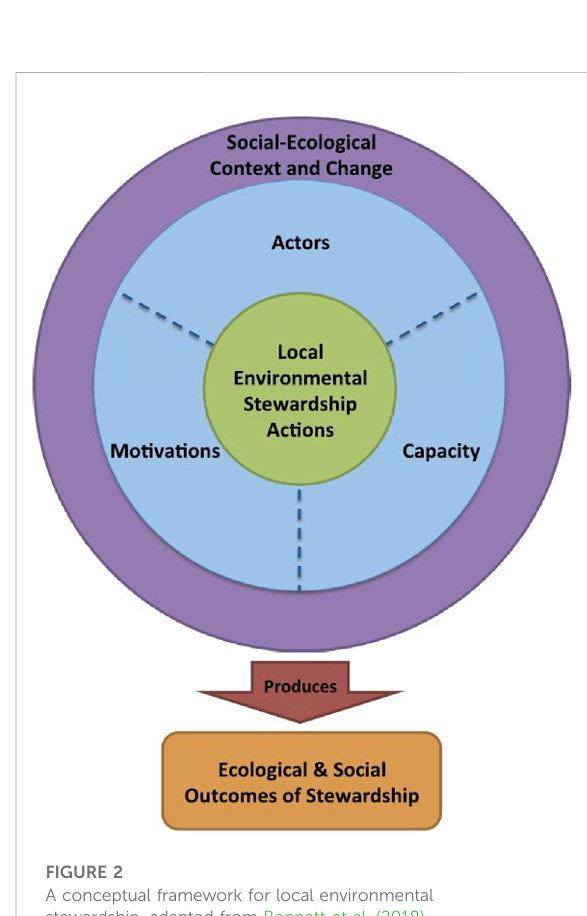
A conceptual framework for local environmental stewardship, adapted from Bennett et al.